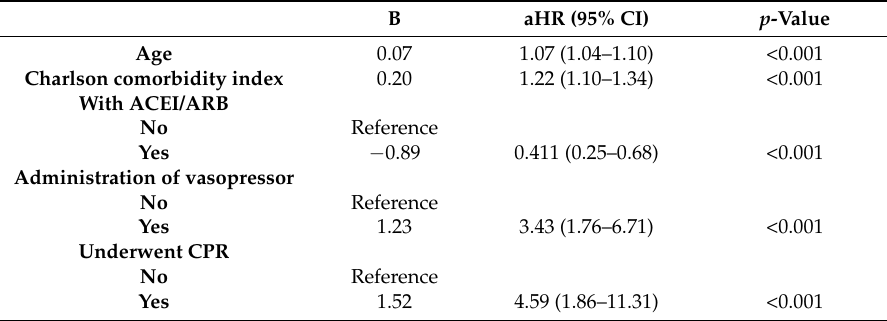
Table 2. Independent predictors of 12-month mortality.